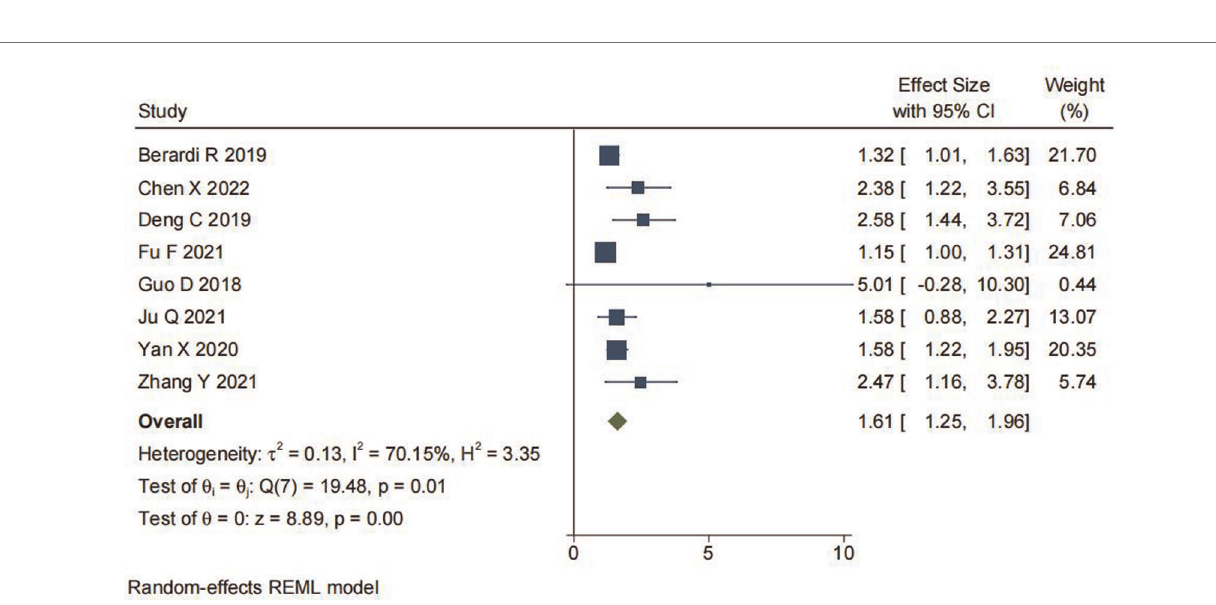
FIGURE 3 | Forest plot depicting the relationship between SII levels and PFS in